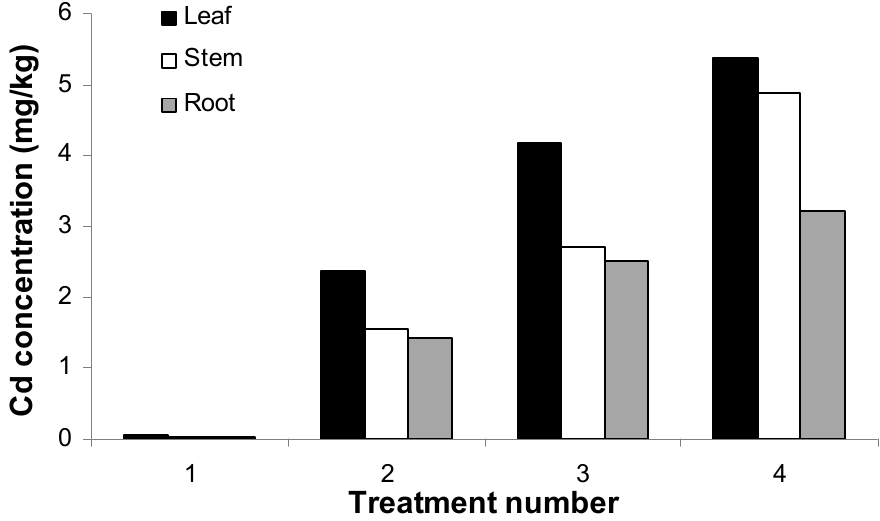
Figure 1. Comparison of the mean total cadmium (Cd) concentrations for different parts of the vegetables and for different treatments (1: 0 mg/kg Cd; 2: 30 mg/kg Cd; 3: 60 mg/kg Cd; 4: 120 mg/kg